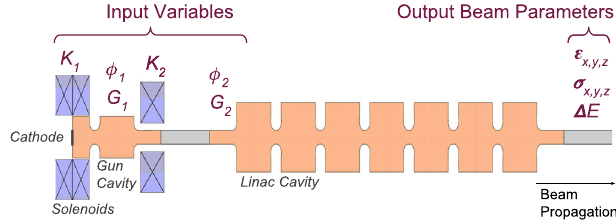
FIG. 3. Schematic of the AWA linac, together with the controllable accelerator settings and predicted beam parameters. The randomly varied inputs include the injector rf phase ϕ 1 and accelerating gradient G 1 , the linac cavity rf phase ϕ 2 and accelerating gradient G 2 , and two solenoid strengths K 1 and K 2 . The output electron beam parameters are the transverse spot sizes σ and σ , the bunch length σ , the transverse projected emittance x y z values ε and ε , the longitudinal projected emittance ε , and the x y z energy spread Δ E . The input variable ranges are determined by typical operating ranges at the AWA and are shown in Table I. We examined this setup for 40 and 1 nC bunch charges.